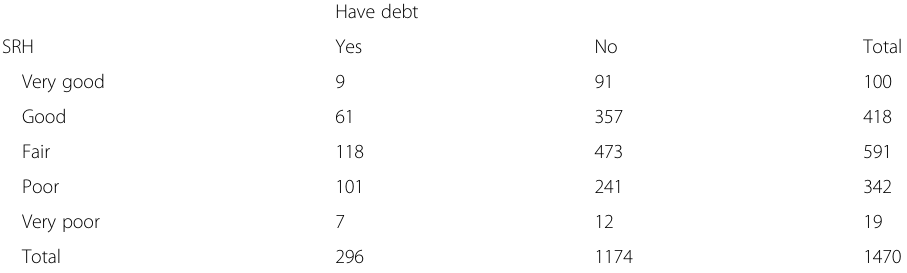
Table 4 Elders ’ SRH and